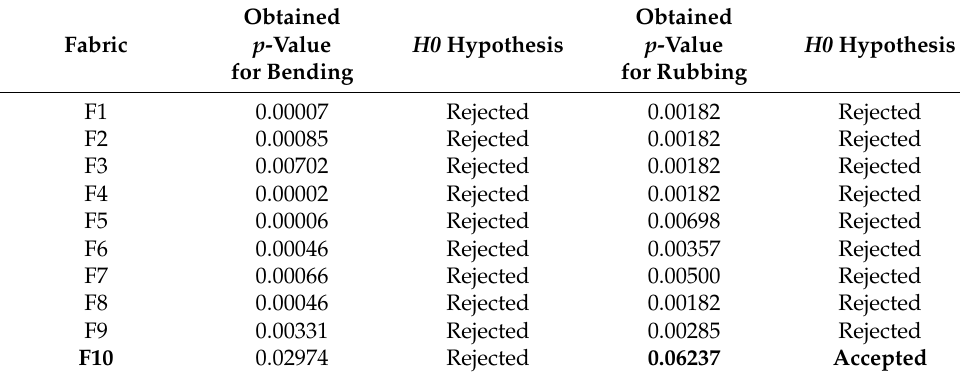
Table 4. Results of Anova Friedman non-parametric tests for the standard deviation of the character- istic impedance.